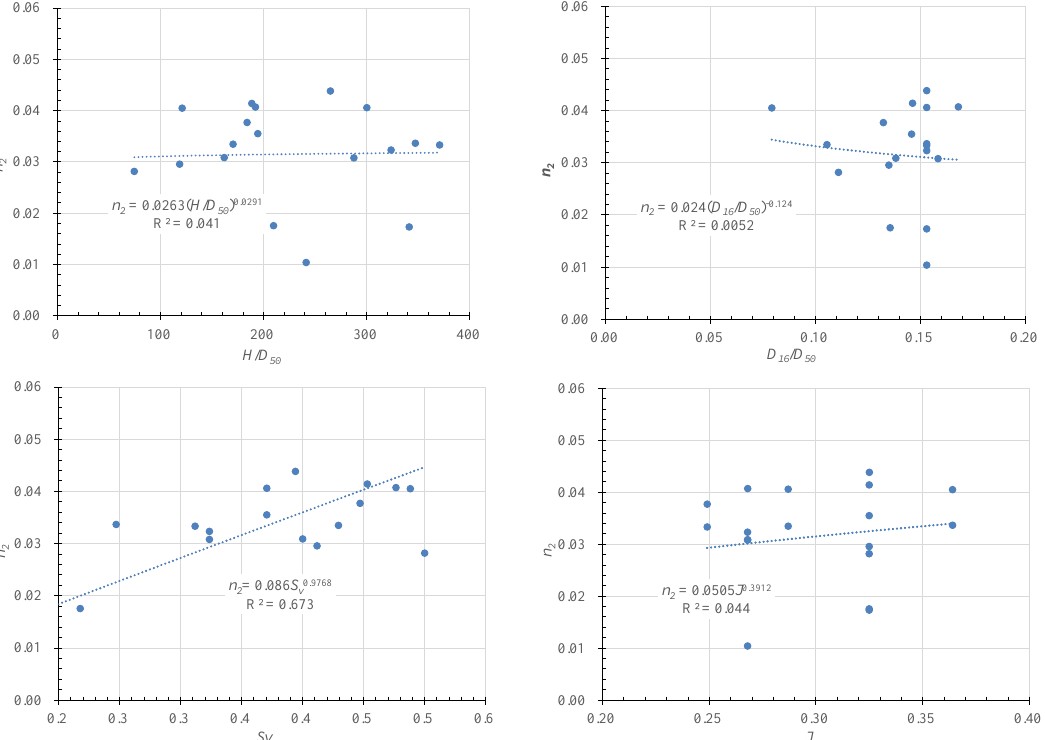
Figure 7. The correlation between the internal roughness n 2 and H / D 50 , D 16 / D 50 , Sv , and J.